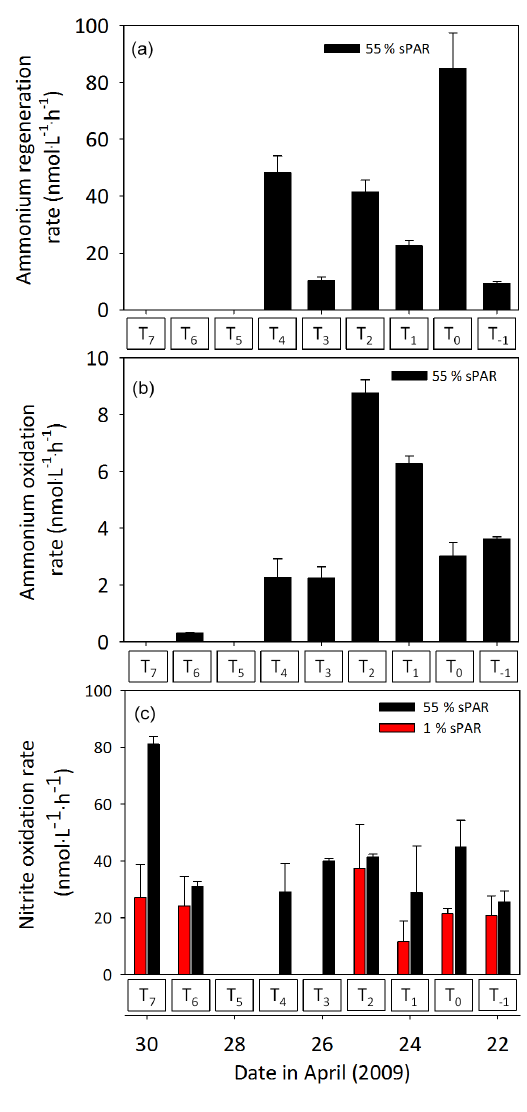
Figure 6. Changes in the rate of ammonium regeneration (a) , am- monium oxidation (b) , and nitrite oxidation (c) for samples taken within the mixed layer depth at 55 and 1% sPAR. Error bars repre- sent 1 standard deviation for triplicate rate measurements. Note the reversal of dates to aid comparisons between